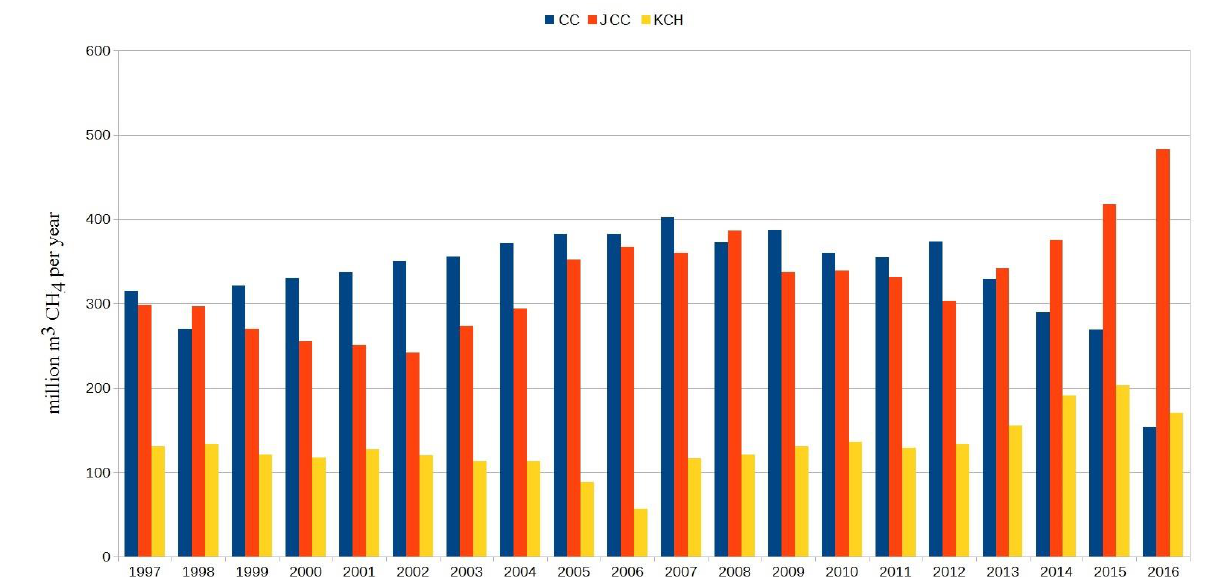
Fig. 6. Absolute methane emissions, ventilation air methane content and mine degassing in USCB